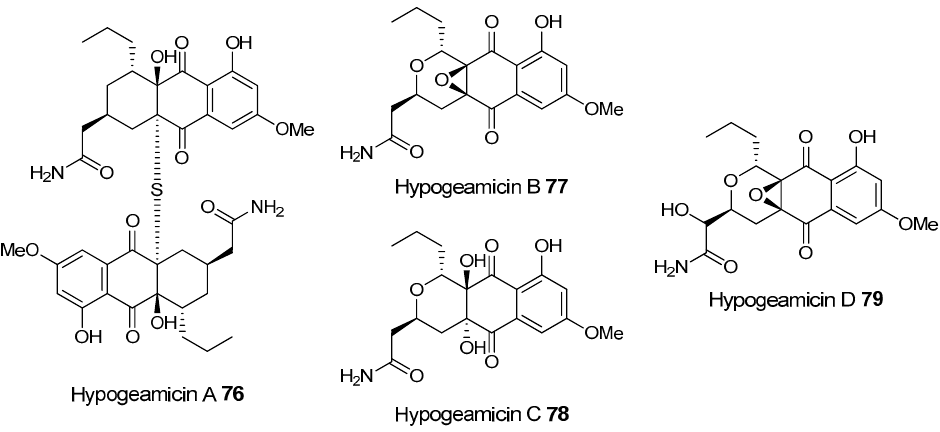
Figure 19. Type II polyketides isolated from an Actinomycetes isolate from Hardin’s